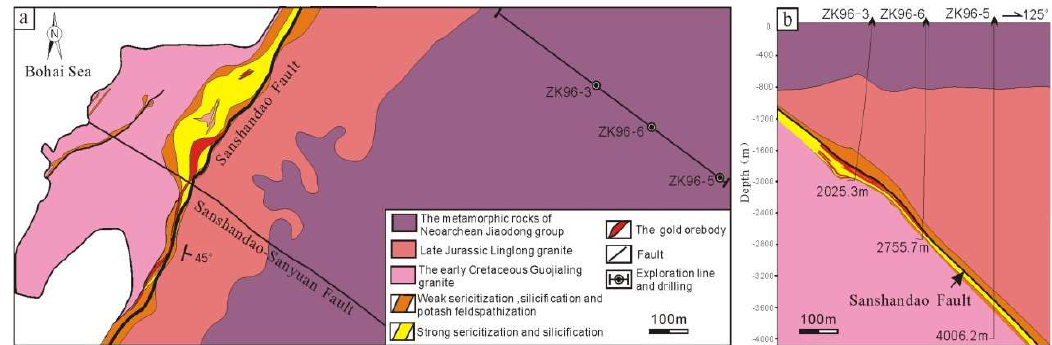
Figure 2. Simplified geological map ( a ) and geological cross section ( b ) of the Sanshandao gold deposit [21]. deposit